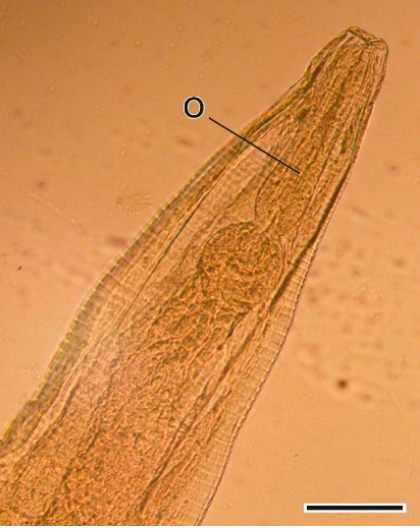
Figure 10. Cephalic extremity of a Syphacia nigeriana female. O, oesophagus. Scale bar = 100 µm.